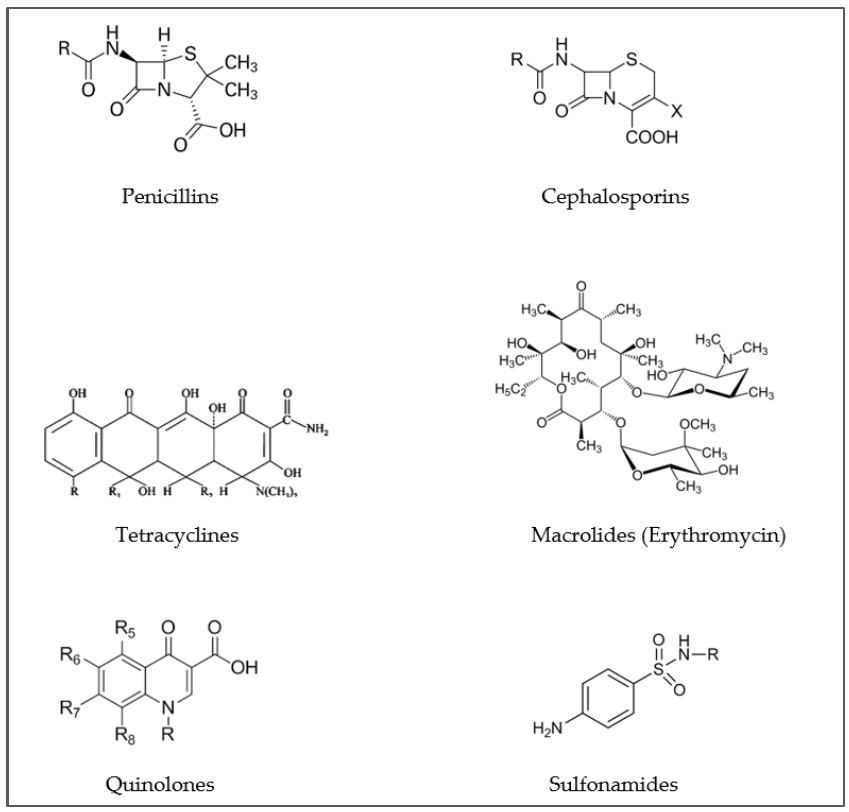
Figure 1. Basic structures of the most used antibiotics in both human and veterinary fields.